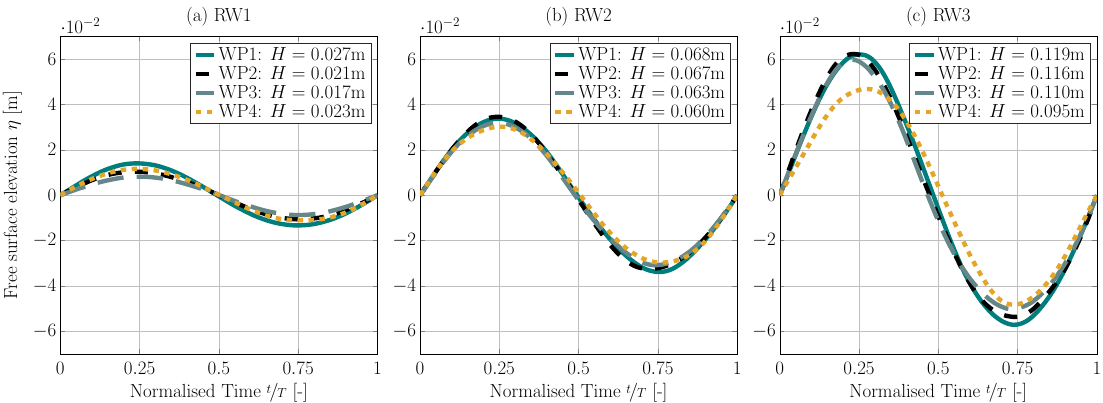
Figure 5. Phase-averaged free surface elevation, measured at wave probes WP1–WP4 (see Figure 1), for waves RW1 ( a ), RW2 ( b ), and RW3 ( c ). Table 3. Wave height, H , and the mean standard deviation, ¯ σ , normalised against the mean wave height, from the experimental data for waves RW1–RW3. RW1 WP1